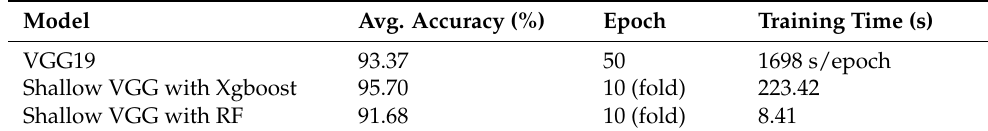
Table 8. Model performances along with required training time.